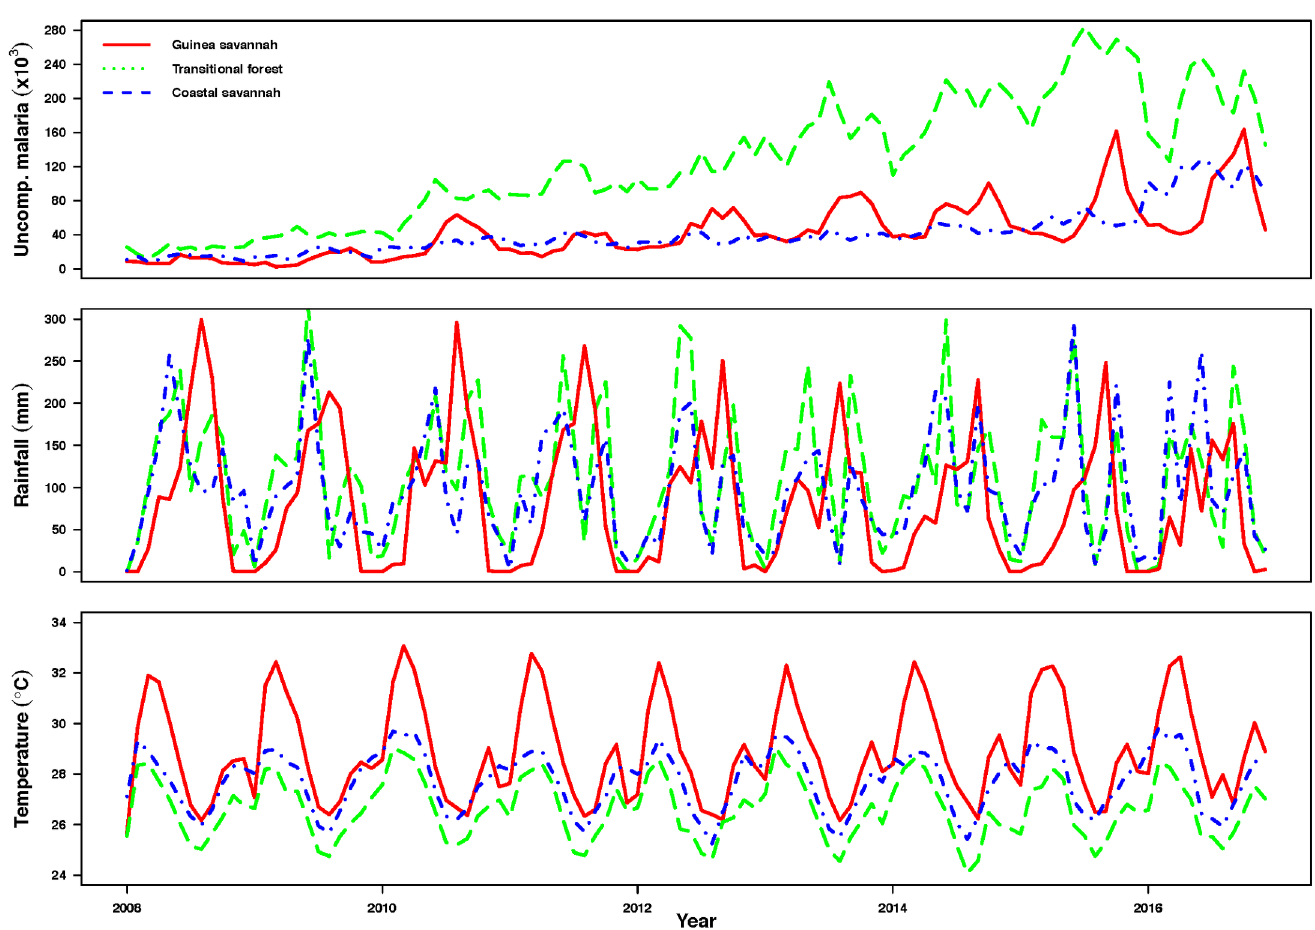
Fig 2. (Top panel) Patterns of uncomplicated malaria morbidity, (Middle panel) average rainfall (mm) and (Lower panel) average temperature (˚C) by year for the Guinea savannah, Transitional forest and Coastal savannah zones.